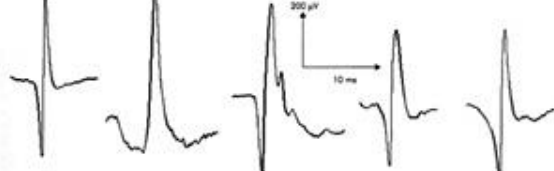
Fig. 1. Examples of potentials at the time of muscle contraction [2].